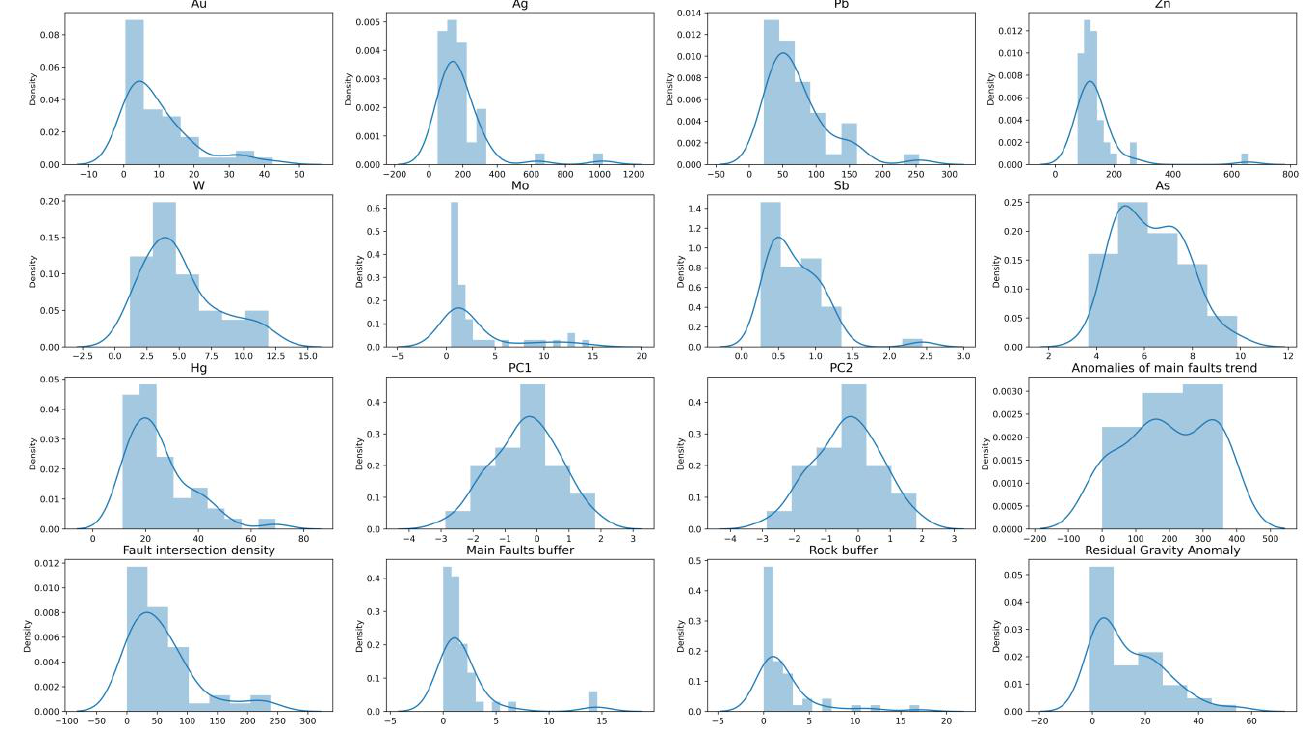
Figure 3. Distribution Histogram for Geological exploration dataset in the Xiong’ershan area.